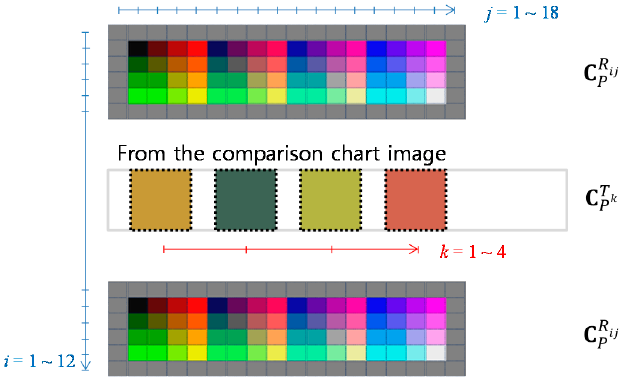
Figure 1. Notations for color information obtained for calibration.